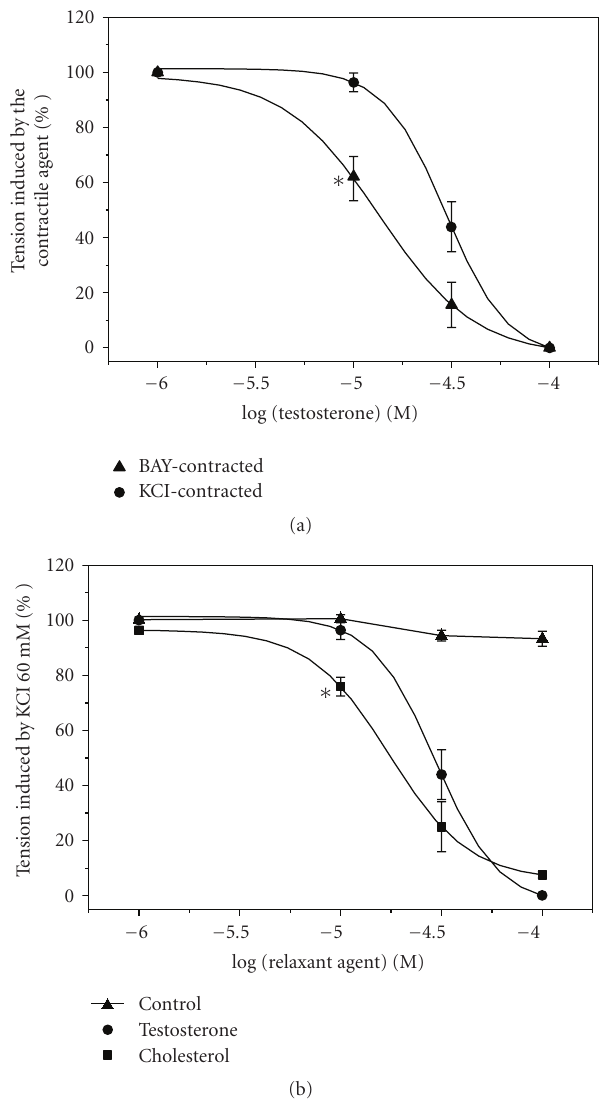
Figure 1: Vasorelaxant e ff ect of testosterone and cholesterol on rat aorta. (a): E ff ect of cumulative concentrations of testosterone (1–100 μ M) on contractions elicited by KCl (60Mm) and BAY (0.1 μ M). (b): E ff ect of cumulative concentrations of testosterone and cholesterol (1–100 μ M) on contractions elicited by KCl (60mM). Control curve with the e ff ect of the steroids solvent used (ethanol) is also shown. Each point represents the mean value and the vertical lines indicate SEM of at least 5 experiments. ∗ P < . 05 versus testosterone e ff ect on KCl contractions, Student’s t